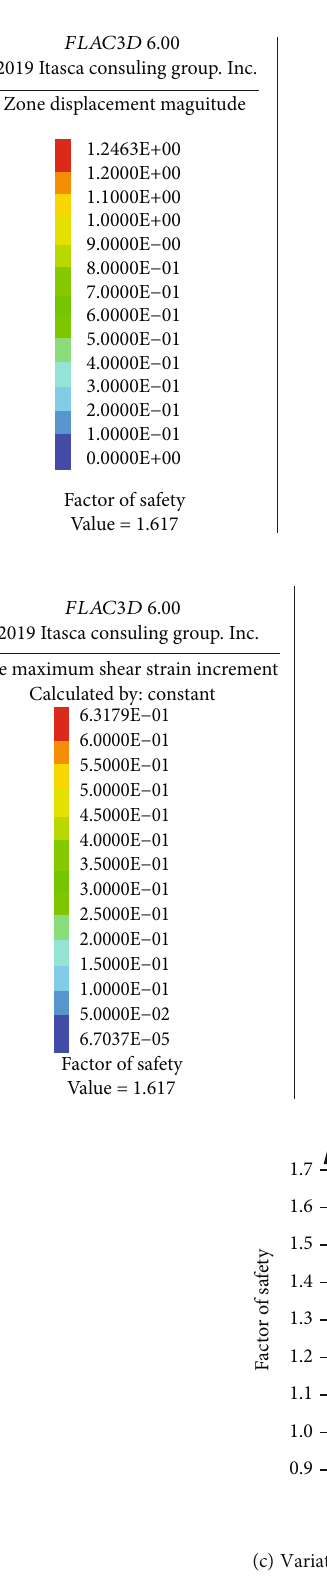
Figure 17: E ff ect of water content on slope